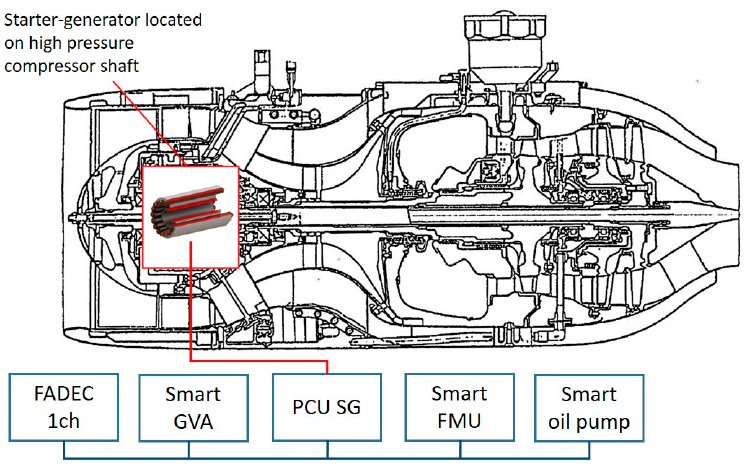
Figure 3. Small size UAV engine concept.